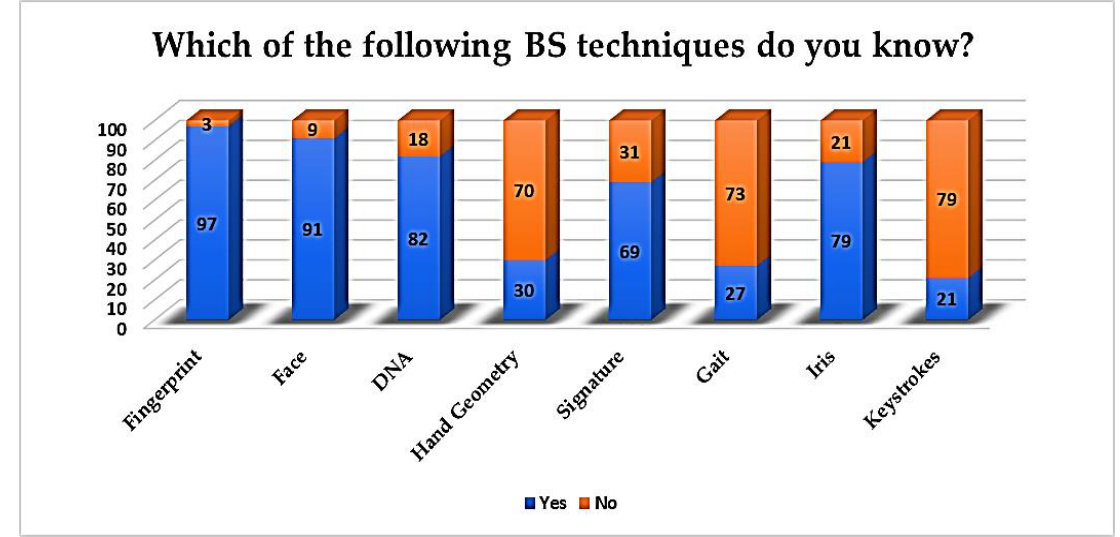
Figure 5. Acknowledged BS techniques .